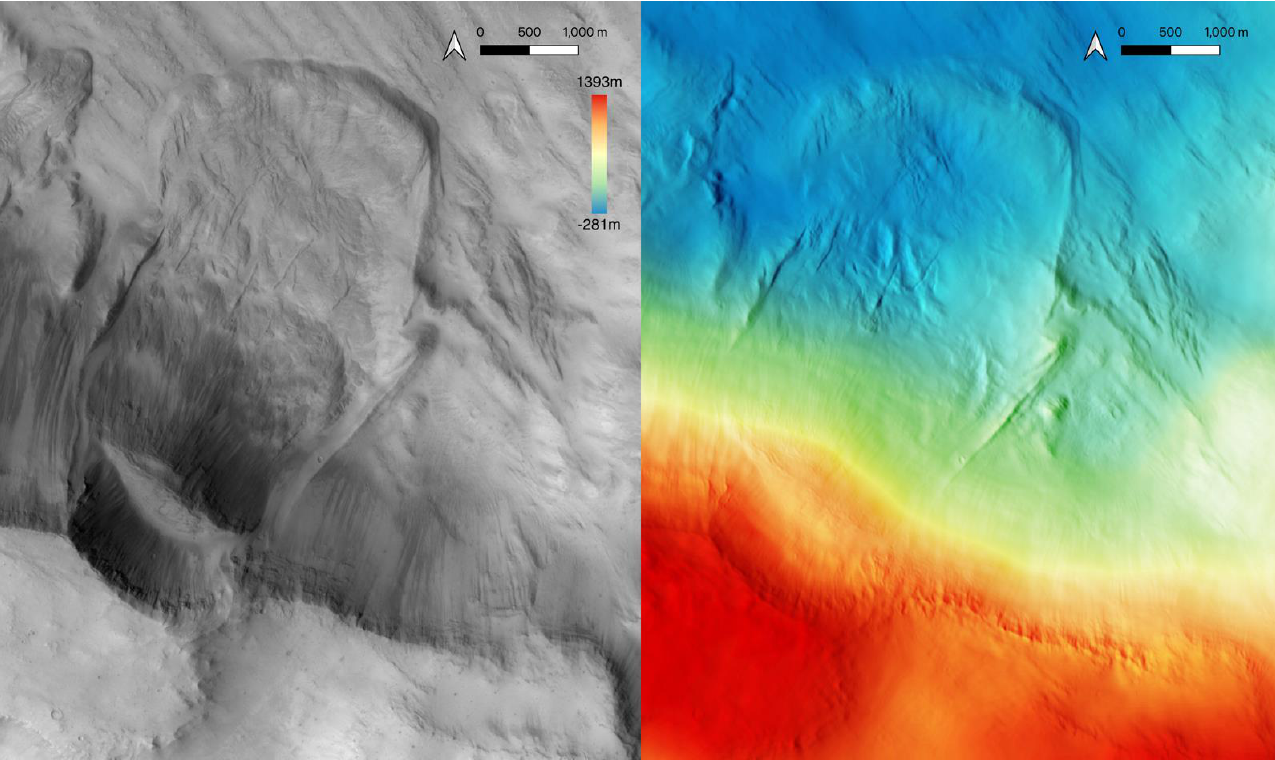
Figure 11. A crop of the 4 m/pixel CaSSIS image and 8 m/pixel MADNet CaSSIS DTM (colourised and hillshaded using similar solar angle as the image) showing landslide at site 1. The landslide is located on a steep escarpment. Part of the plateau has displaced downslope and a nearly intact block of plateau material is now located mid-slope. The southeast-to-northwest ridge and trough texture on the floor of the depression is the ejecta from an impact crater located to the southeast. To look into details—please refer to the full-resolution figures provided in Supplementary Materials.